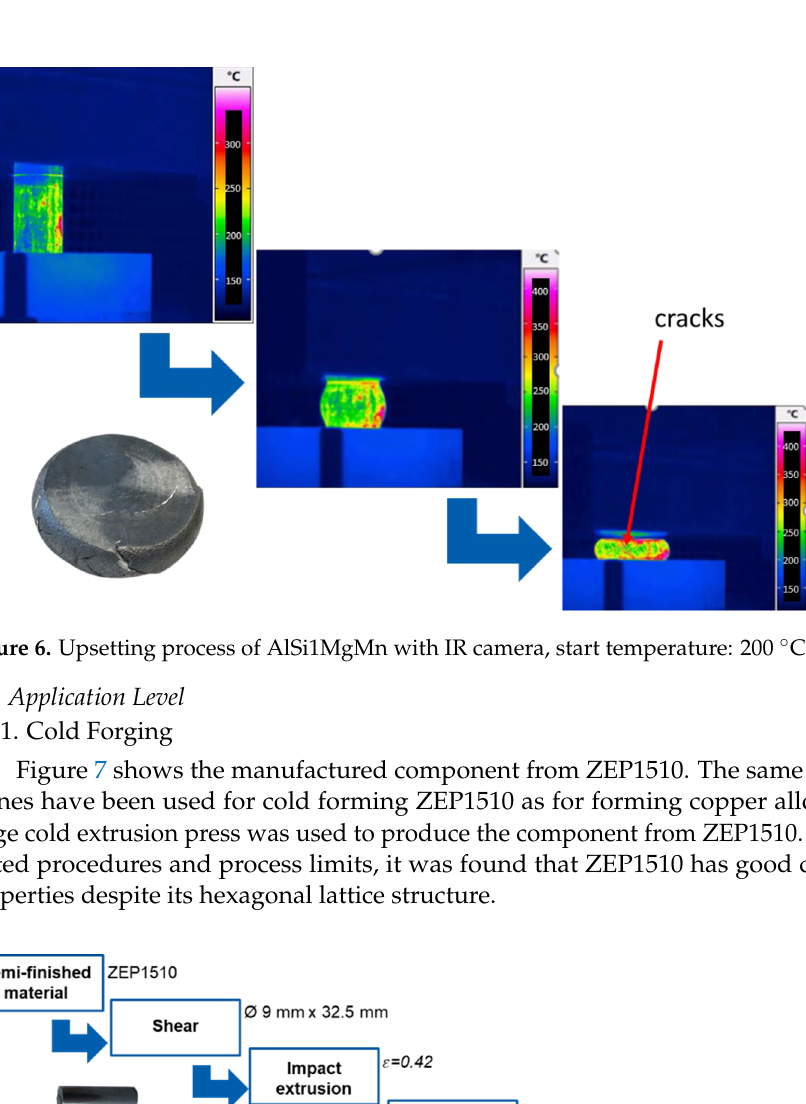
Figure 6. Upsetting process of AlSi1MgMn with IR camera, start temperature: 200 °C.